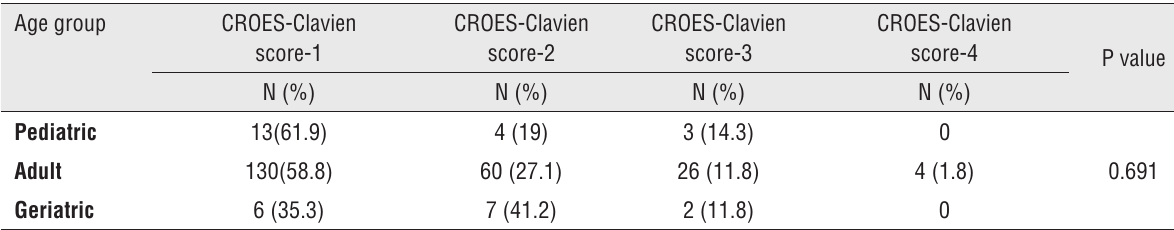
Table 5 - complications based on cROEs-clavien score across different age groups. Age